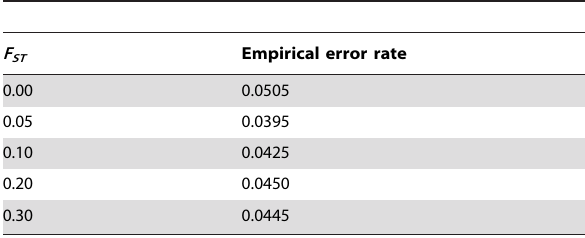
Table 1. Empirical type-1 error for 500K GWAS at genome- wide significance level 0.05.